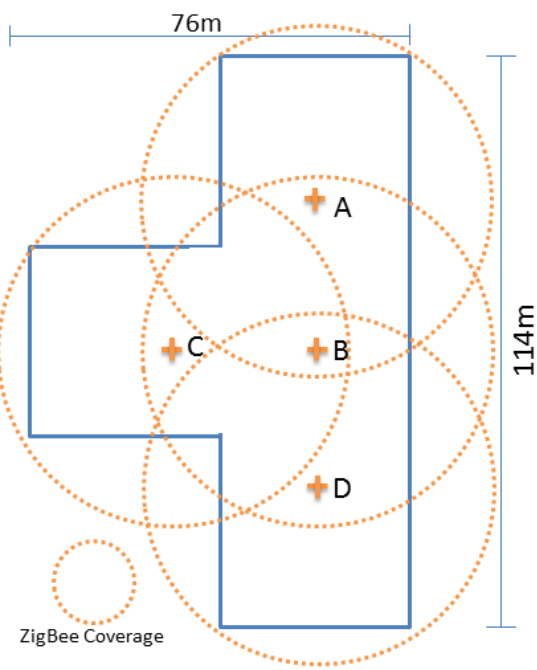
Figure 5. Simplified floor